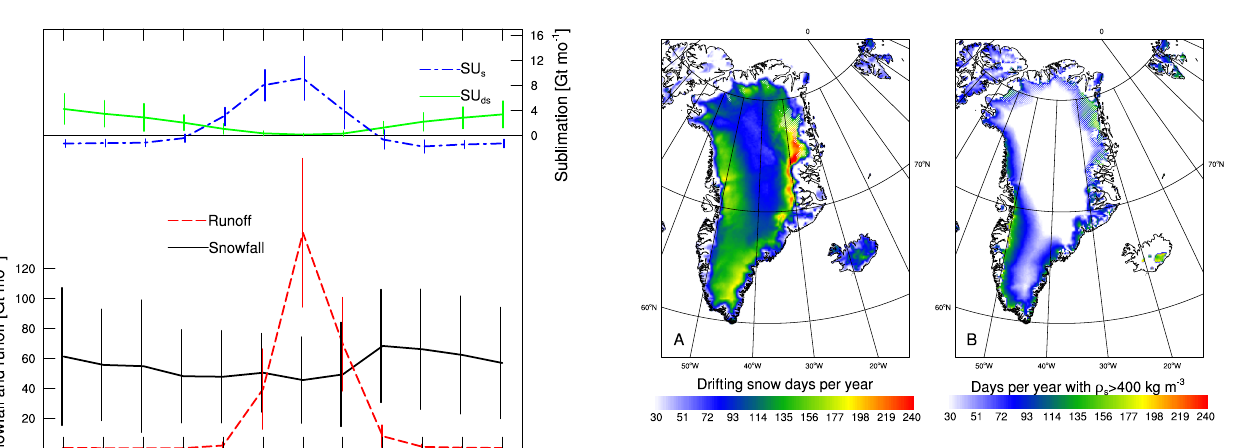
Fig. 8. Number of drifting snow days (with SU ds > 0 ) per year and number of days with snow density of the upper 5cm of the snowpack ( ρ s ) greater than 400kg m − 3 . White dashes indicate areas with a standard deviation > 30